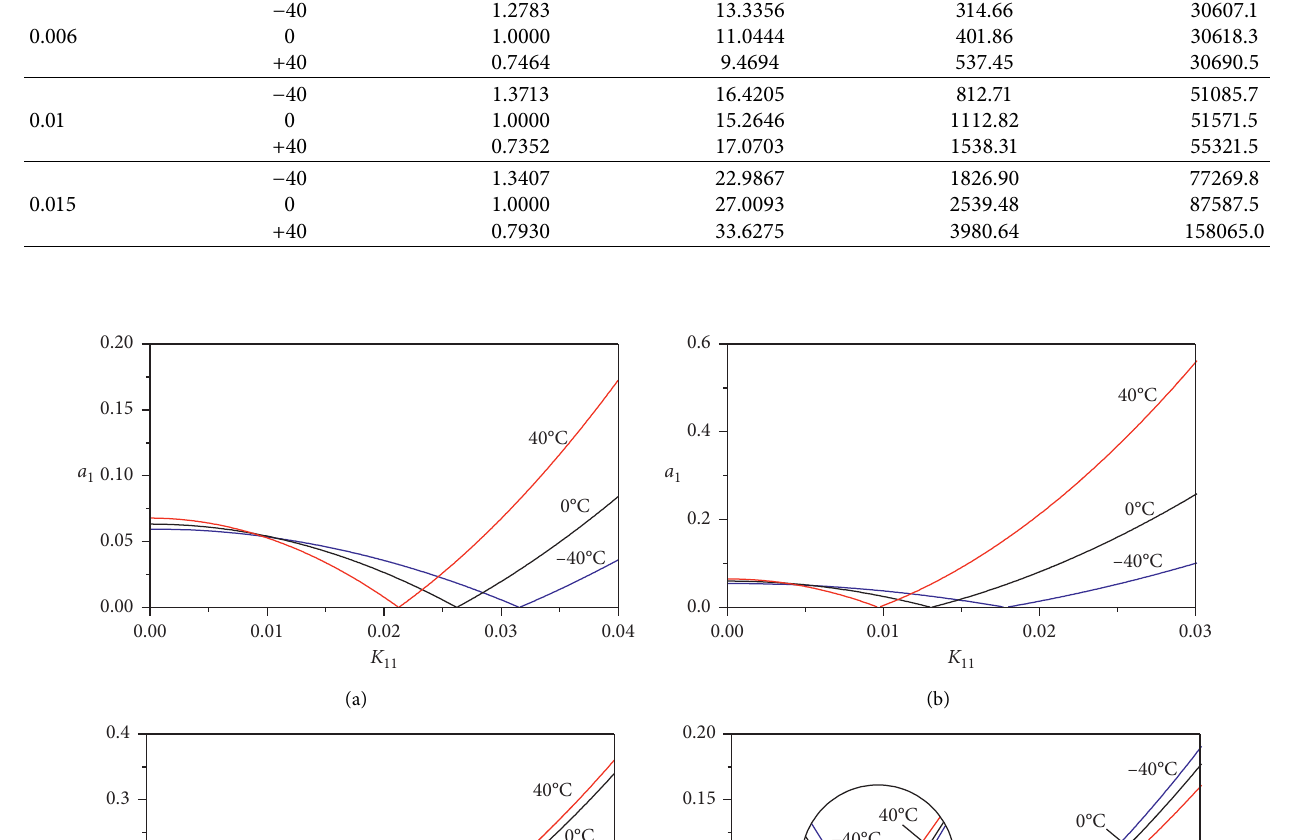
� 0 . 0001 in Case when K 1 21